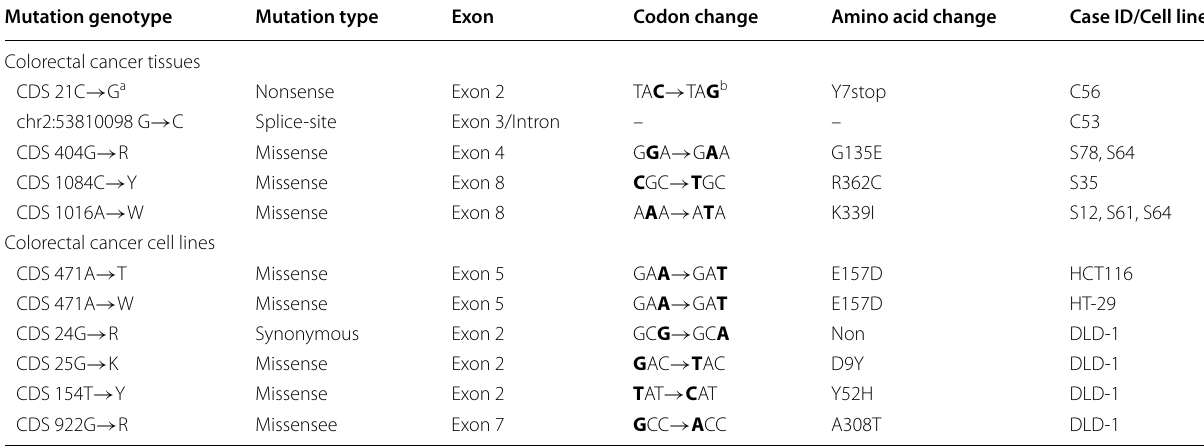
ASB3, ankyrin repeat and suppressor of cytokine signaling (SOCS) box protein 3 The nucleotides in bold indicate the one mutated a CDS coding domain sequence; A, T, C, G, four types of nucleotides; R b amino acid